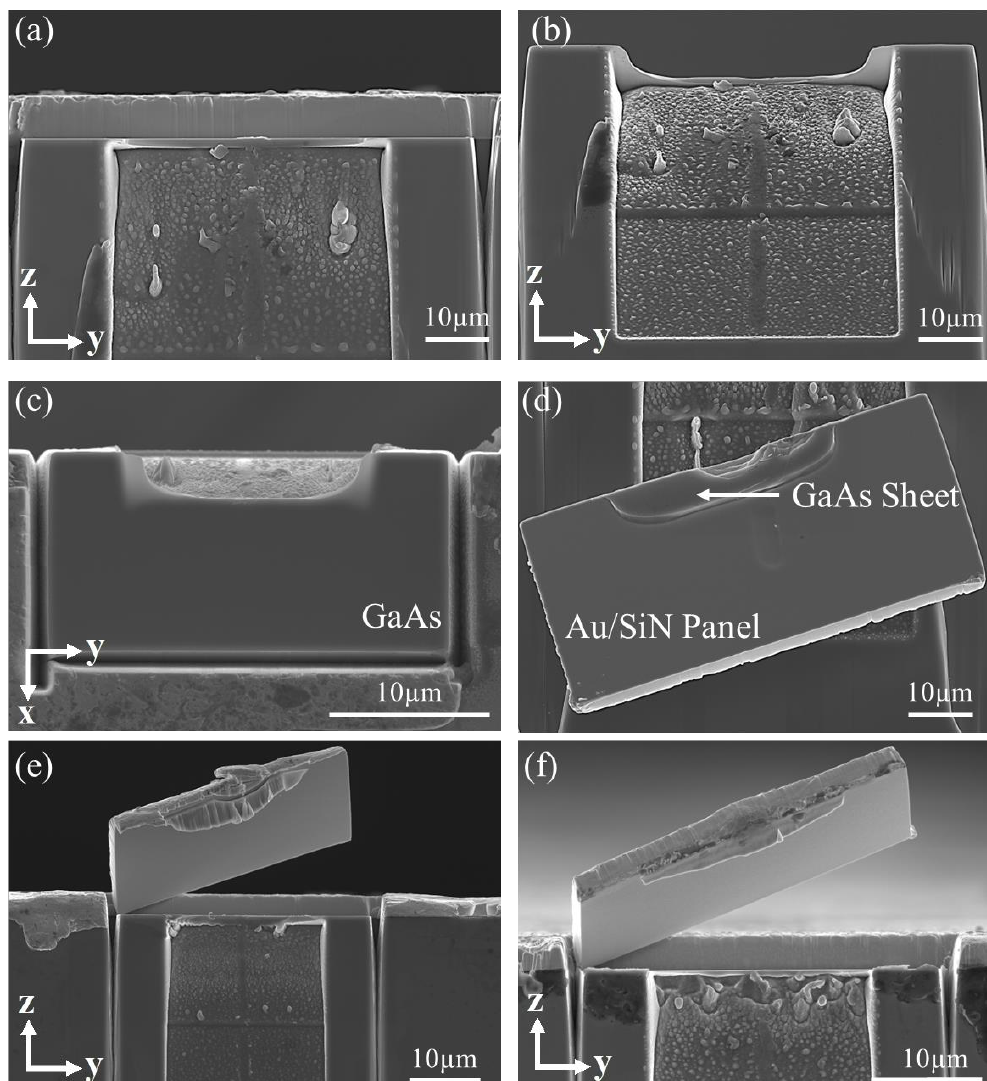
Figure 5. SEM post-mortem examination of a typical specimen (S2) after the push-out test, showing the detachment of the SiN/Au panel from the GaAs substrate: ( a ) cross-section; ( b ) side view with 40° tilting angle; ( c ) top surface showing the fresh exposed GaAs surface after the Au/SiN panel was peeled off; ( d ) the detached SiN/Au panel (the panel was picked up by a micro-manipulator and placed on the sample for SEM observation; the GaAs thin sheet separated from the substrate can be seen); the detached panels of S1 and S5 are provided in ( e , f ),